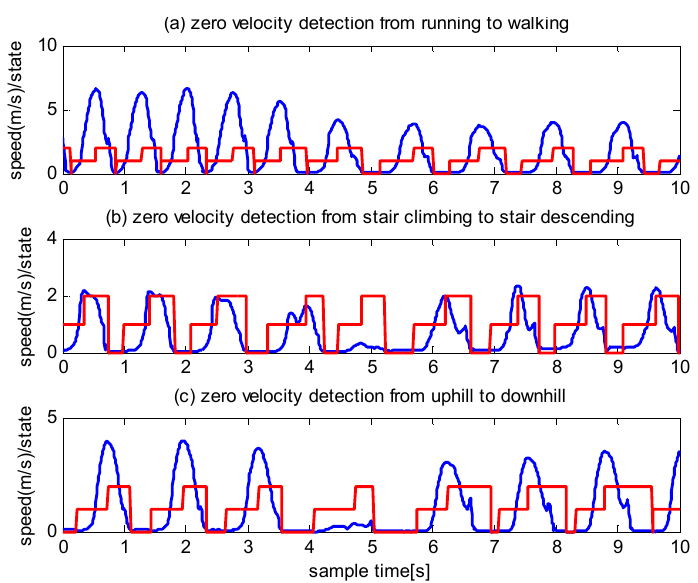
Figure 8. Zero velocity detection using the method proposed in this paper.